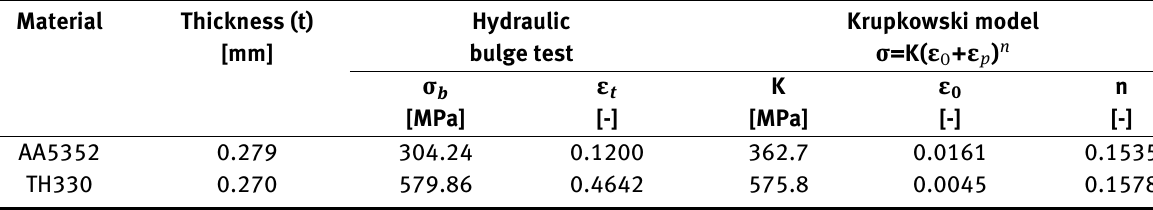
Table 2: Material properties obtained from hydraulic bulge test and Krupkowski hardening curve Material